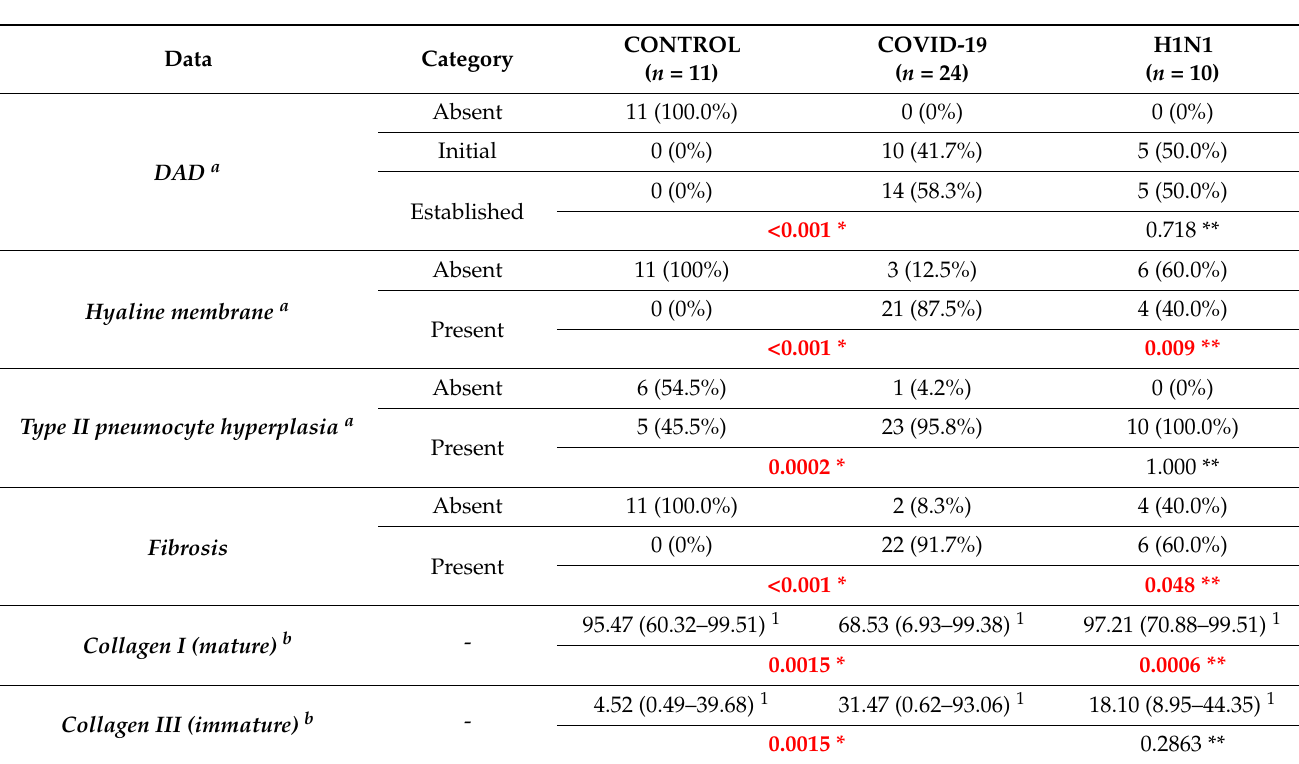
Table 2. Histopathological findings and morphometric evaluation of Collagen I (mature) and III